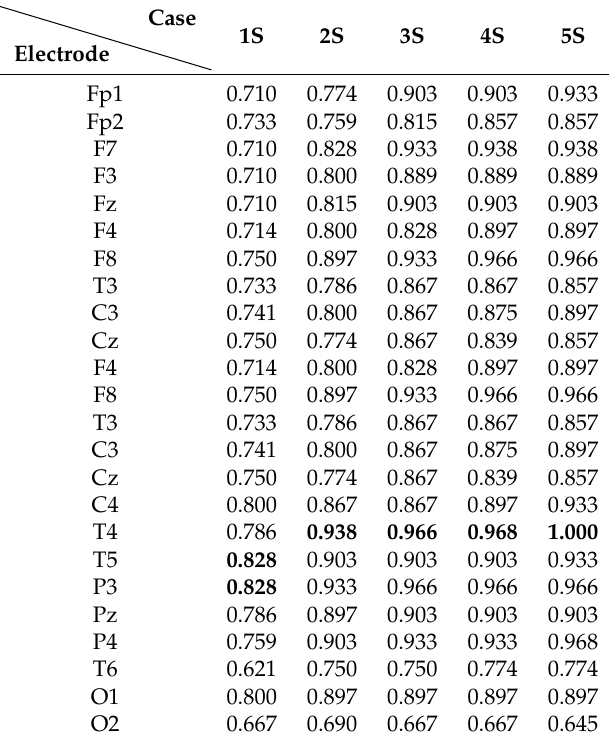
Table 1. Optimal F1 scores of LOOCV in differentiating subjects into the HC and AD2 groups of each electrode obtained using 1–5 MSE scales (labeled as 1S–5S), respectively. Bold highlights the best performances.